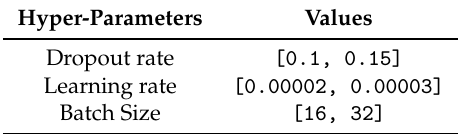
Table 12. Explored combination of the bare BERT-base hyper-parameters during the fine-tuning.